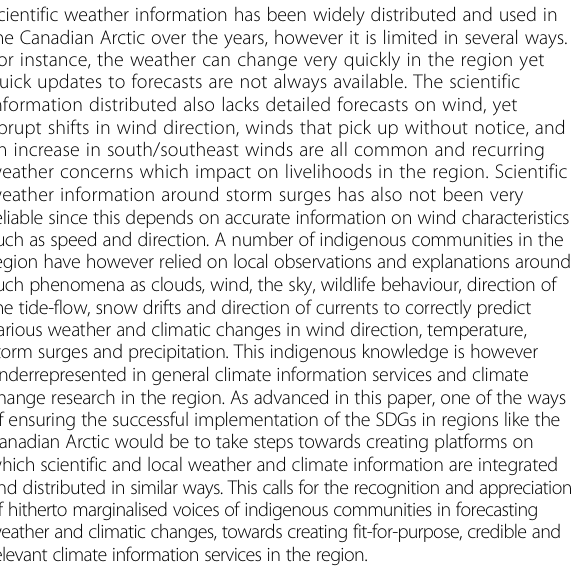
Table 3 Climate information services in the Canadian